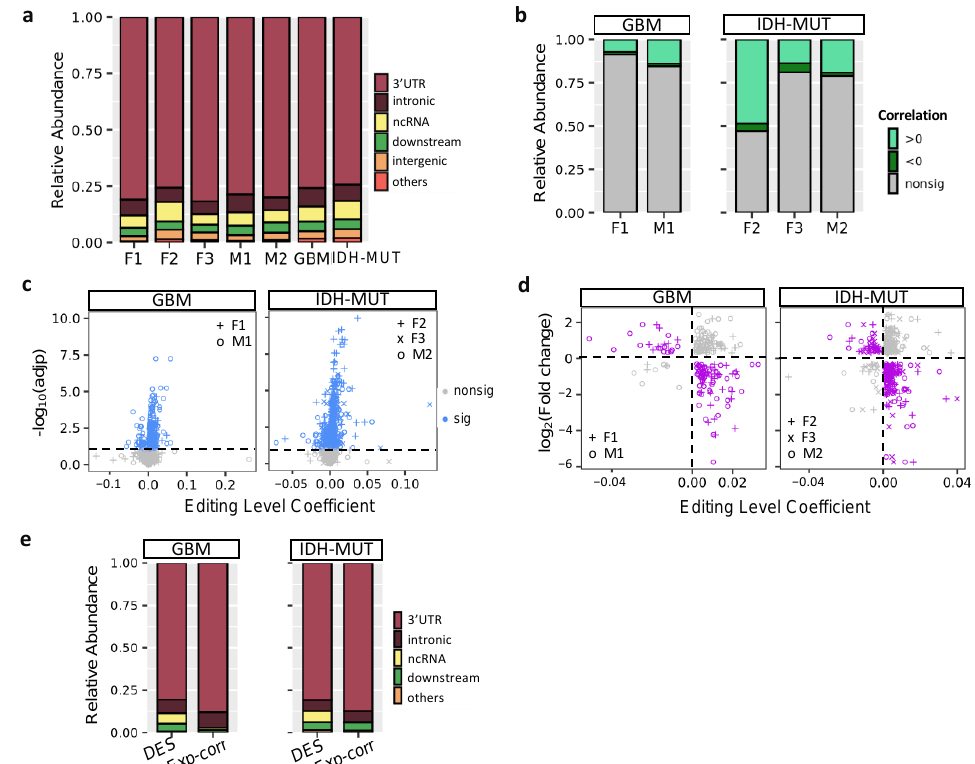
Figure 5. Regulatory potential of RNA editing in mRNA abundance. ( a ) Location of differentially edited sites (DESs) between high- and low-risk gliomas. Comparisons are made for GBM (F1: G 2 vs. G 1 and M1: G 1 vs. G 2 ) and IDH-MUT gliomas (F2: GH vs. ODI 1 ; F3: ODI 2 vs. ODI 1 and M2: GHI 1 vs. GHI 2 ). ( b ) Distribution of correlations between mRNA abundance and RNA editing levels of DESs. ( c ) Scatter plot of coefficient and significance of editing level as a predictor of mRNA abundance, controlling for age. For genes with multiple sites associated with mRNA abundance, the one with the smallest adjusted p value was selected. Dashed line represents significance threshold at 10% false discovery rate. ( d ) Scatterplot of editing level coefficient estimate from ( c ) and fold change of the corresponding gene upon ADAR1 KD cells. Purple points represent the direction of expression alterations in line with the sign of the editing association, whereas gray points represent the opposite. ( e ) Editing sites correlated with expression (Exp-corr) tend to locate in the 3 (cid:48) UTRs, compared to all DESs (excluding intergenic